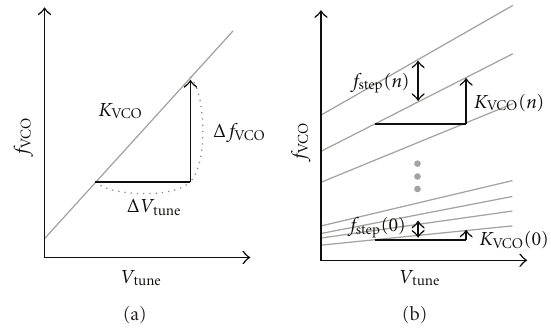
Figure 1: Frequency tuning characteristics in a wide band VCO. (a) Single tuning curve. (b) Multiple tuning curves with K VCO ( n ) and n ) variation. f step (